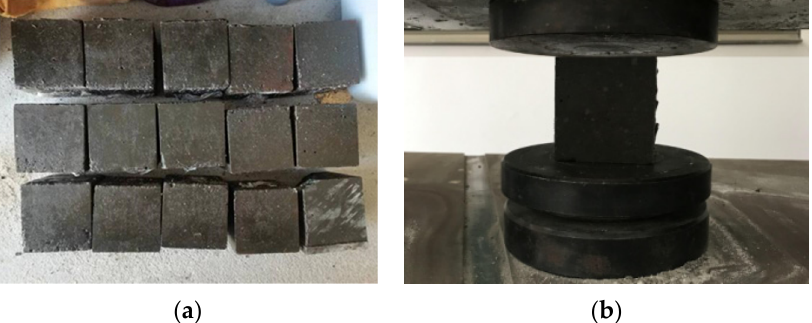
Figure 3. Cube specimen of the compressive strength test and test process. ( a ) test specimen; ( b ) test process.